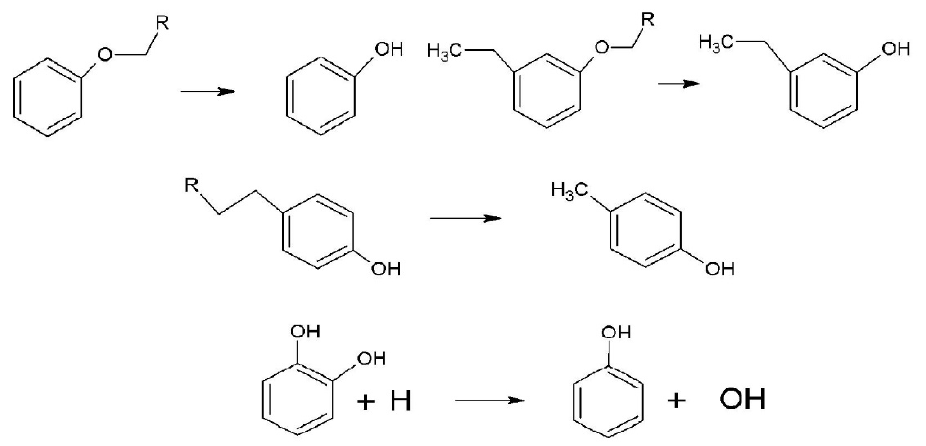
Figure 1. Formation mechanism of phenols [26].